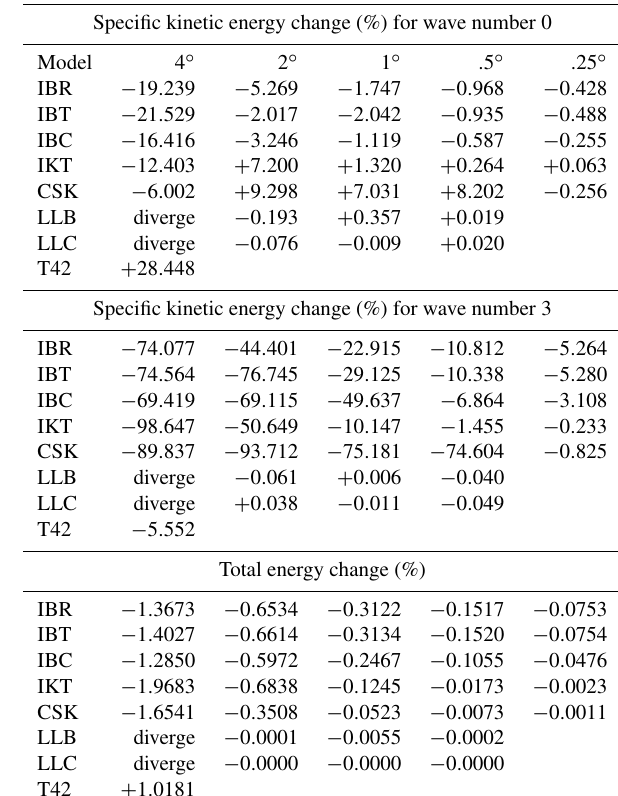
Table 3. Relative change (%) of specific kinetic energy for wave numbers 0 and 3 and total energy for various resolutions and mod- els IBR, IBT, IBC, IKT, CSK, LLB, LLC, and National Center for Atmospheric Research spectral transform model at T42 resolution (Hack and Jakob, 1992) after 40 days of integration. Initial condi- tions are Rossby–Haurwitz wave 3. “Diverge” means the simulation